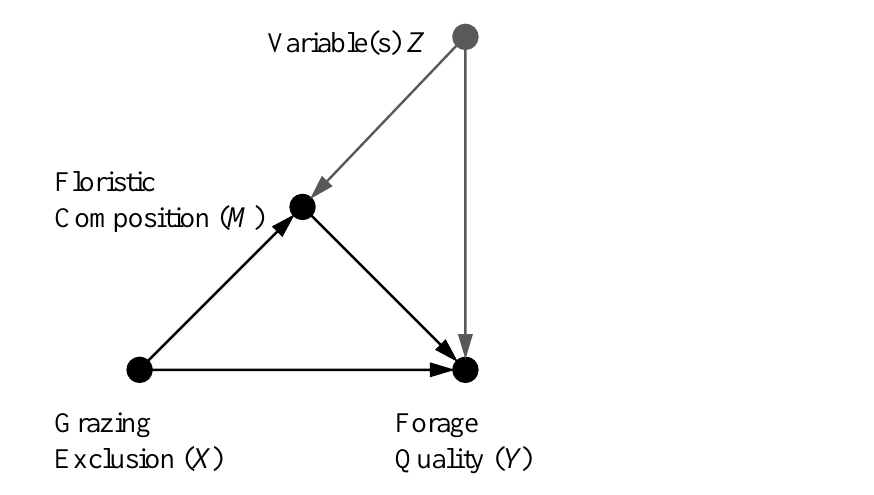
Figure 1. Directed acyclic graph representing direct and indirect (via concurrent change in floristic composition) effects of grazing exclusion ( X ) on forage nutritive quality ( Y ). Floristic composition acts as a mediating variable ( M ). The variable(s) Z denotes potential confounders of the mediator M and the outcome Y . Grazing exclusion ( X ) is a randomized experimental factor, and so stands as a parent node with no incoming arrows. The path from X to Y ( X → Y ) represents the direct effects and the path from X to Y through M ( X → M → Y ) represents the indirect effects, once that the potential confounding effects of the Z variables have been controlled for.